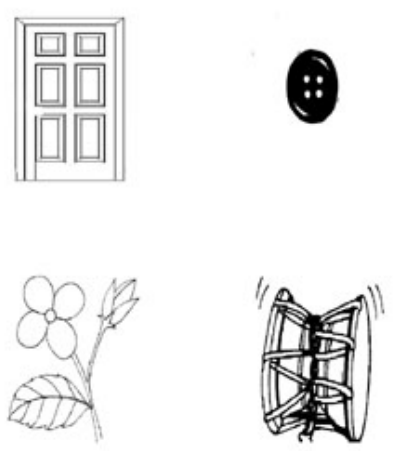
Figure 1 . Example visual display depicting the target object (door) and three unrelated